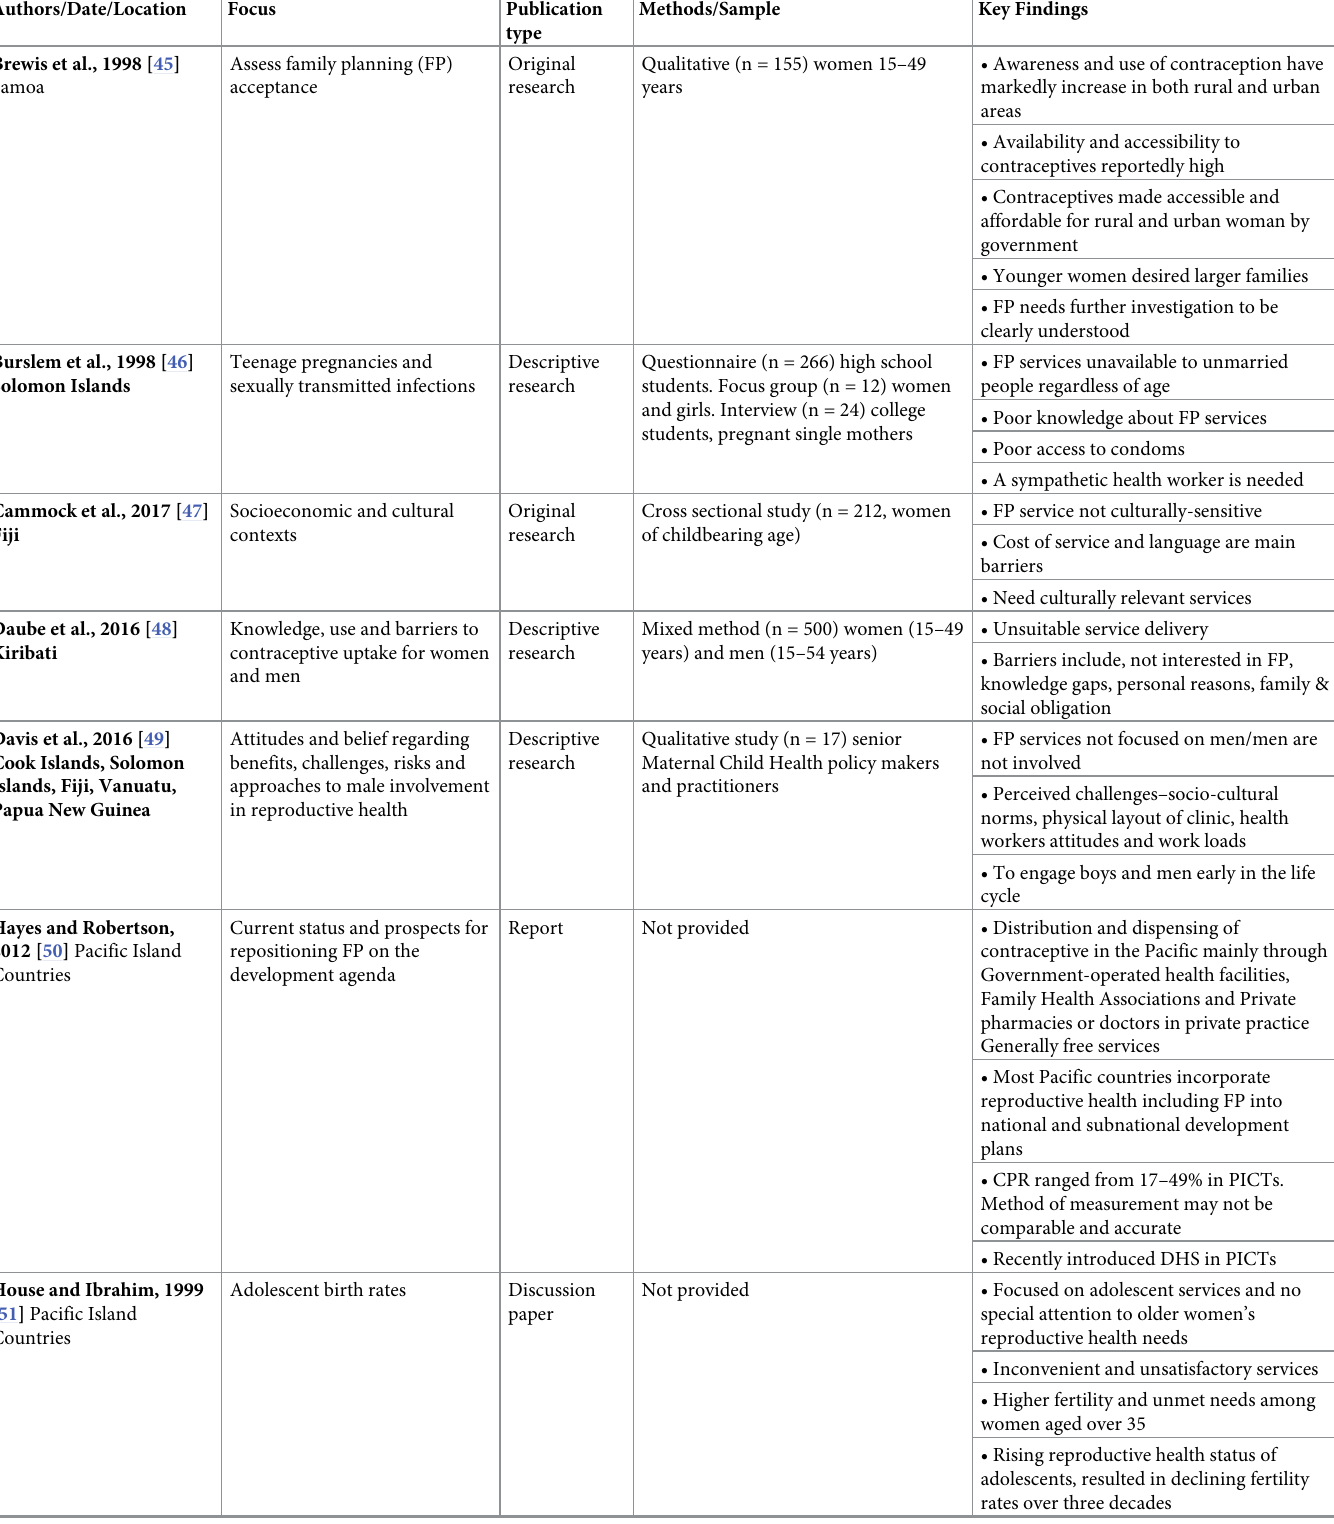
Table 1. Data extraction